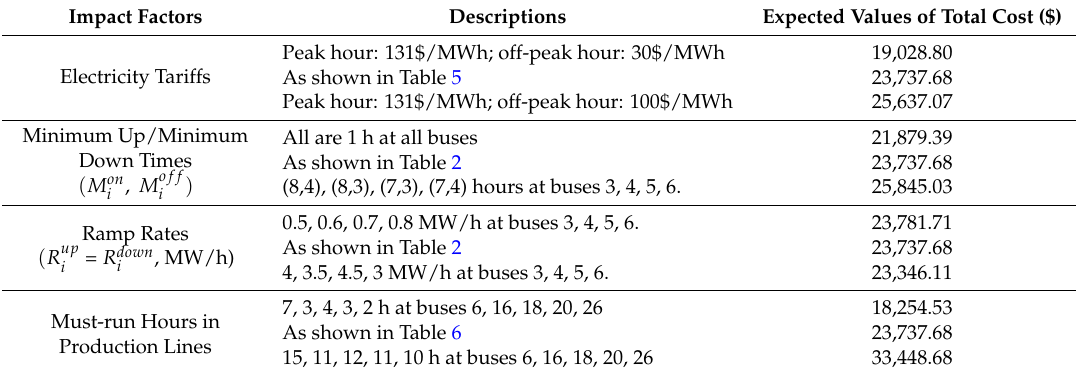
Table 9. Impacts of different factors on